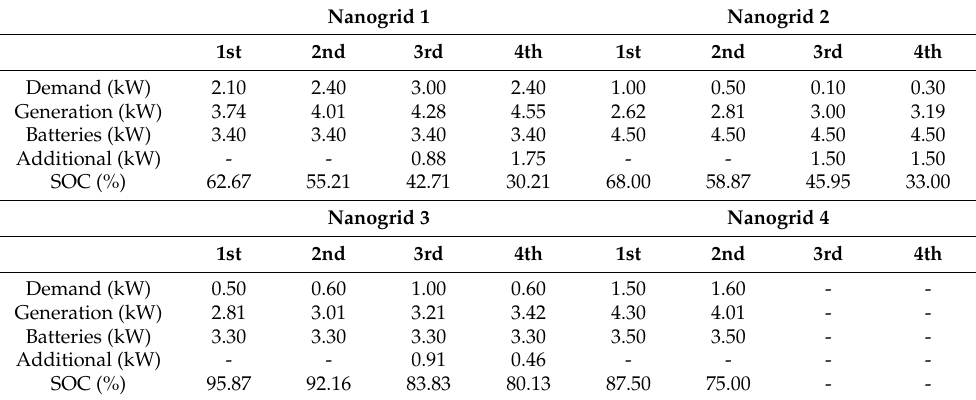
Table 8. Operation of HEMS1-4 while providing the